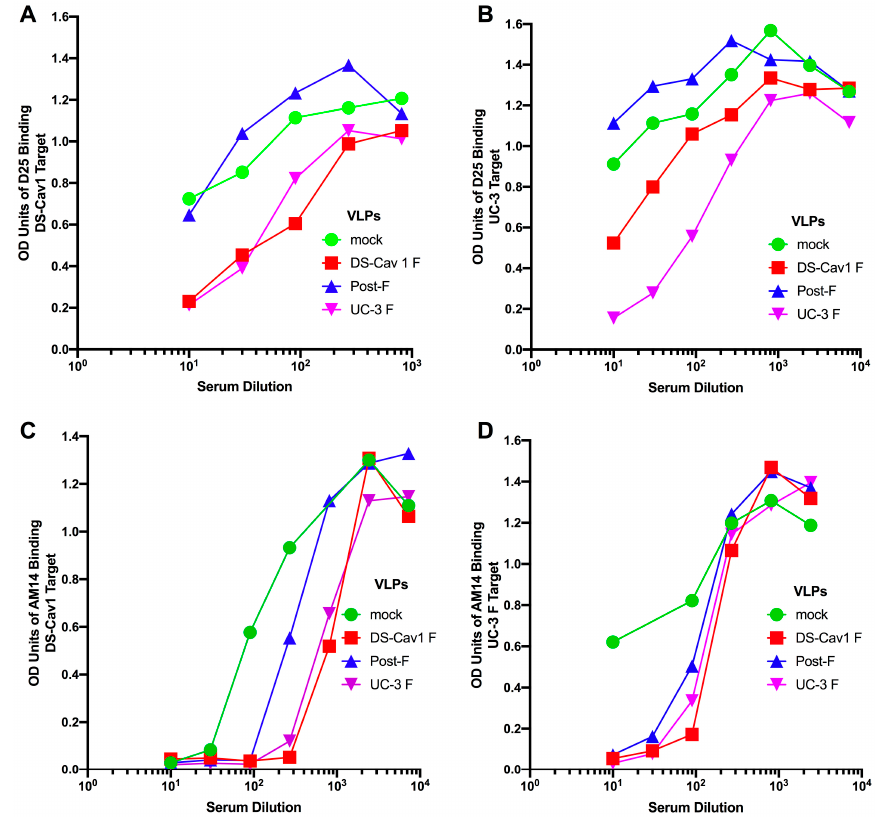
Figure A1. Titration of binding of mAb D25 and AM14 to soluble pre-F targets in presence of di ff erent dilutions of CR dam sera. Shown are illustrations of the determinations of dilution of sera induced by di ff erent VLPs that block 50% of the binding of D25 to soluble DS-Cav1 F (panel A) or UC-3 target (panel B) or that block the binding of mAb AM14 to soluble DS-Cav1 F protein target (panel C) or to soluble UC-3 F target (panel D). Using the total ng / mL of anti-pre-F binding IgG in each serum, the ng / mL of anti-pre-F IgG in the dilution of sera that blocks 50% of the binding of the mAb can be calculated. Total ng / mL of pre-F binding IgG in the dam sera were: Mock, 2.3 × 10 5 ; DS-Cav1 F VLP sera, 4.0 × 10 6 ; post F VLP sera, 5.0 × 10 6 ; UC-3 F VLP sera, 5.5 × 10 6 . Total ng / mL of anti-pre-F IgG in pup sera was 3 × 10 5 ng / mL. All titrations were done two or three